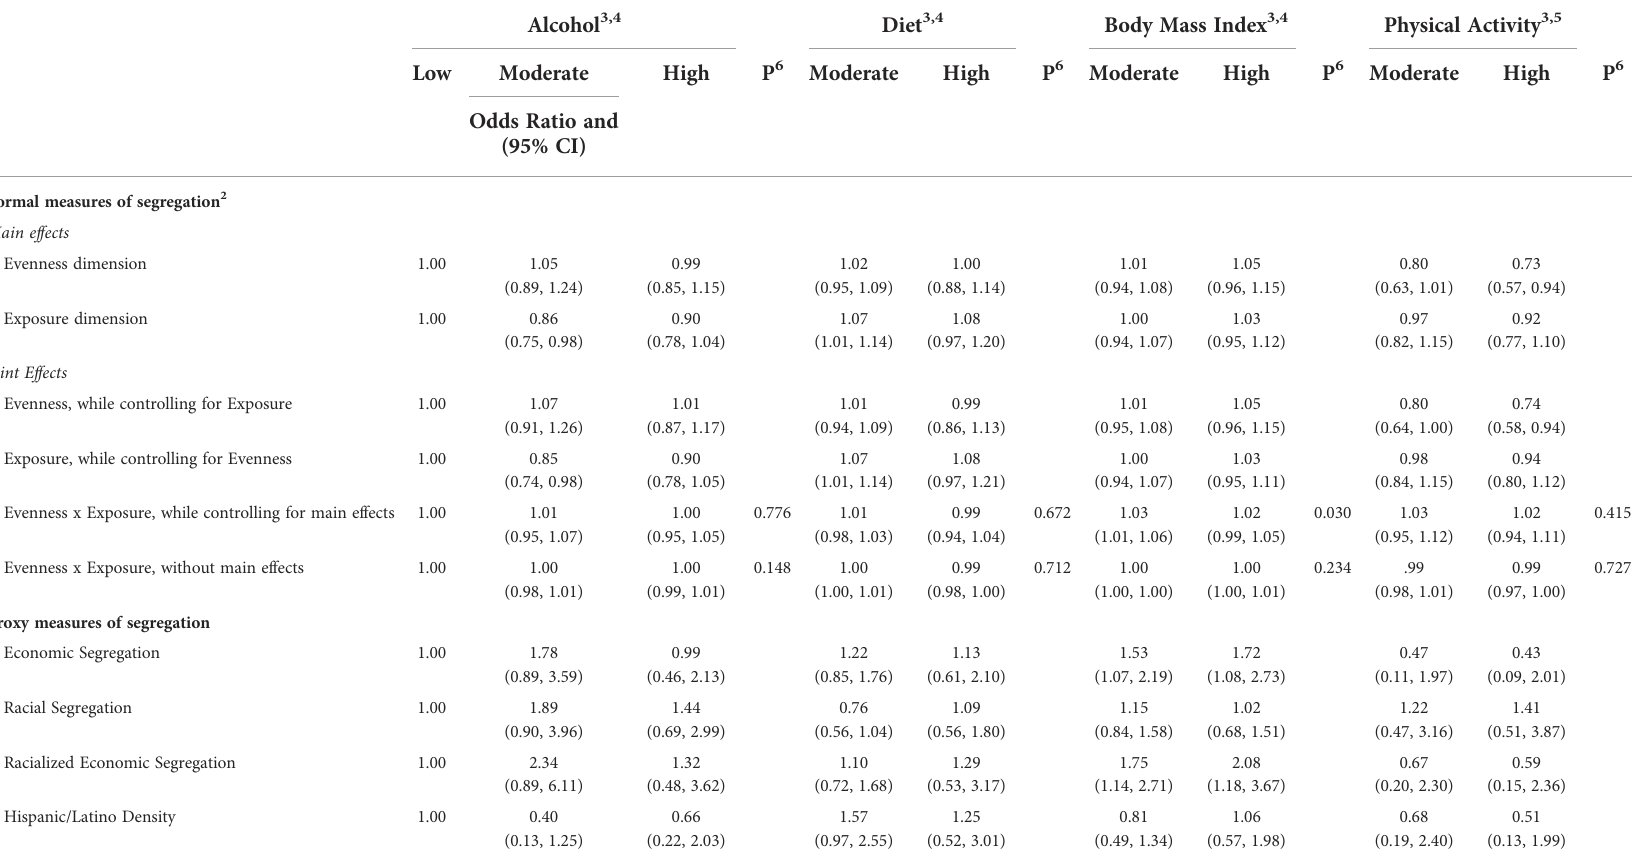
TABLE 7 Multinomial logistic regression models for the association between neighborhood segregation measures and adherence to the individual components of the ACS guidelines 1 on nutrition and physical activity for cancer